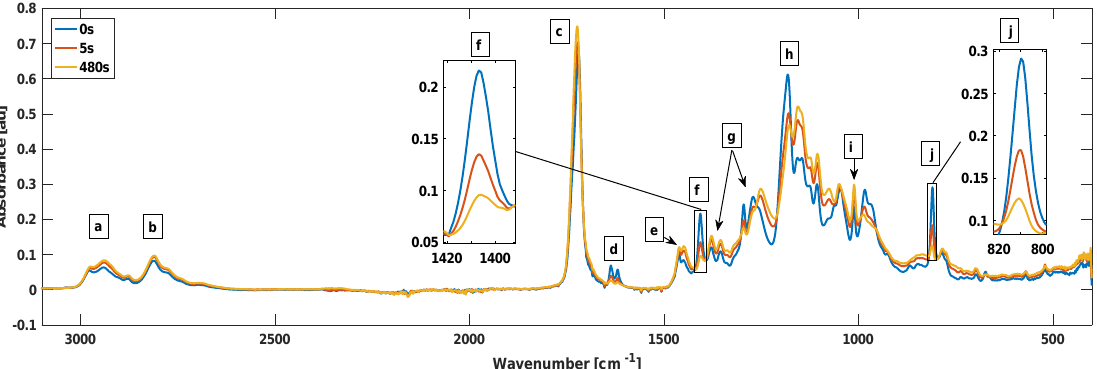
Figure 3. Fourier transform infrared (FTIR) of 300 µ m thick 1,3-AOBAE film mixed with 2.5 wt% diphenyl(2,4,6-trimethylbenzoyl) phosphine oxide (TPO) at different curing times 0, 5 and 480 s. UV cured in N 2 with wavelength 365 nm and 11,9 mW/cm 2 of curing power. Peak f, the O-C=O stretch at 1408 cm − 1 was chosen for the monomer conversion rate calculation.